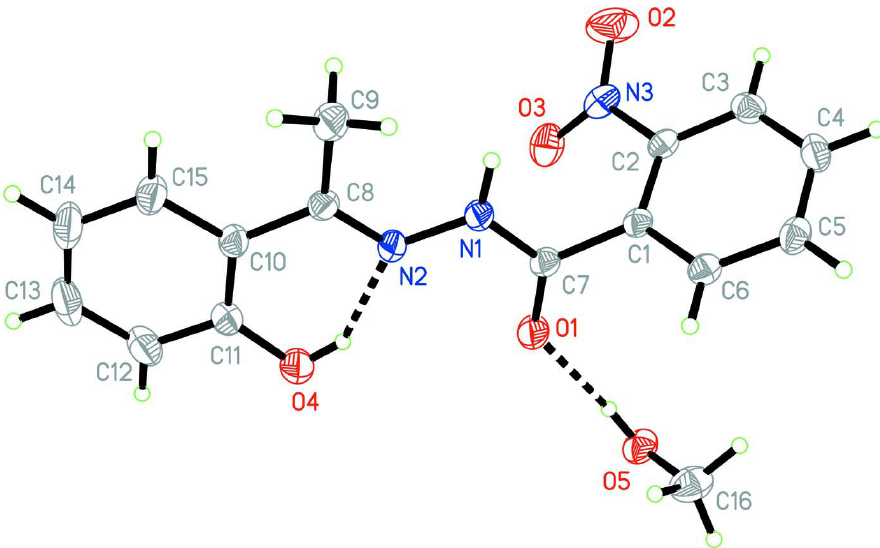
Figure 1 The molecular structure of the title compound, with 30% probability displacement ellipsoids. Hydrogen bonds are shown as dashed